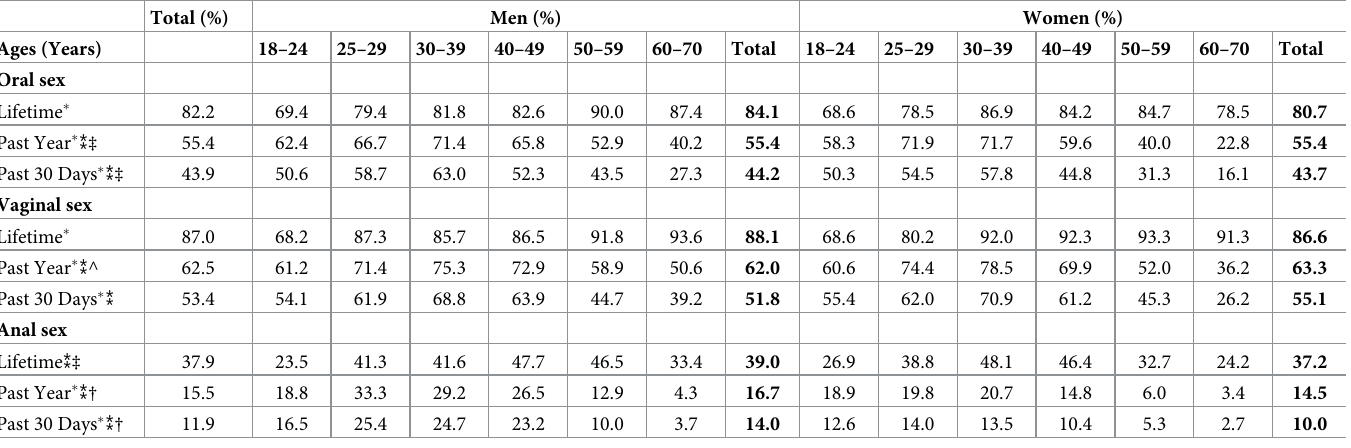
Table 2. Prevalence rates of oral, vaginal, and anal sex for lifetime, past 12 months, and past 30 days ( N = 1,987; men n = 953, women n = 1015).